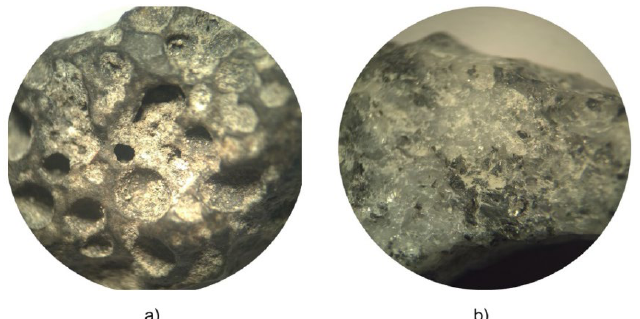
Figure 6. Microscopy images of aggregates, 15x magnification (a) steel slag (b) gneiss coarse aggregate